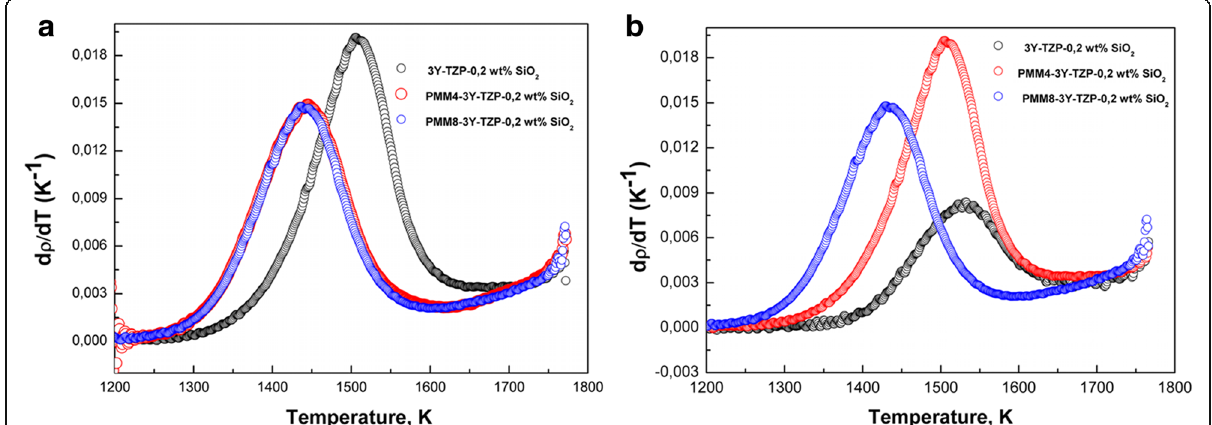
Fig. 7 Temperature dependence of densification rates of ( a ) 3Y-TZP, PM4-3Y-TZP, PM8-3Y-TZP and b 3Y-TZP-0.2 wt% SiO 2 , PMM4-3Y-TZP-0.2 wt%